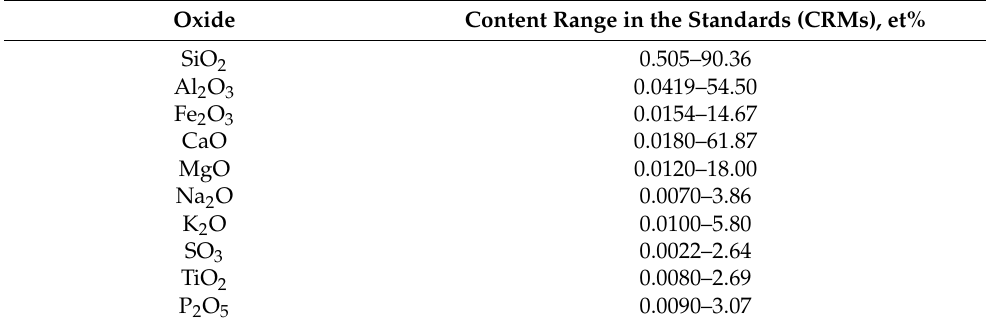
Table 8. Content range of the determined oxides in the standards (CRMs) applied in estimation of the accuracy of the SQX semi-quantitative analysis—content range of the method. Oxide Content Range in the Standards (CRMs), et%